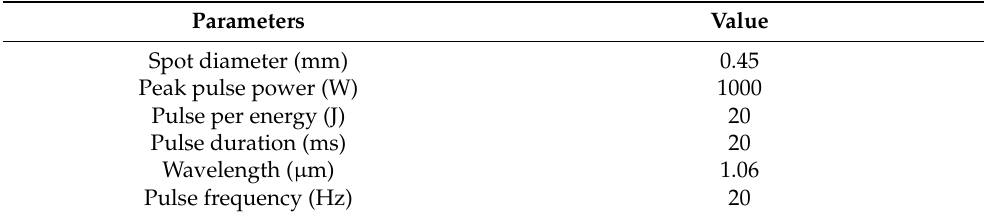
Table 3. Fixed welding parameters during